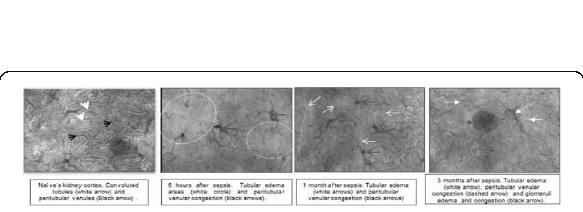
Fig. 2 (abstract 000984). SDF images of the kidney cortex following the sepsis showing microcirculatory injuries up 3 months